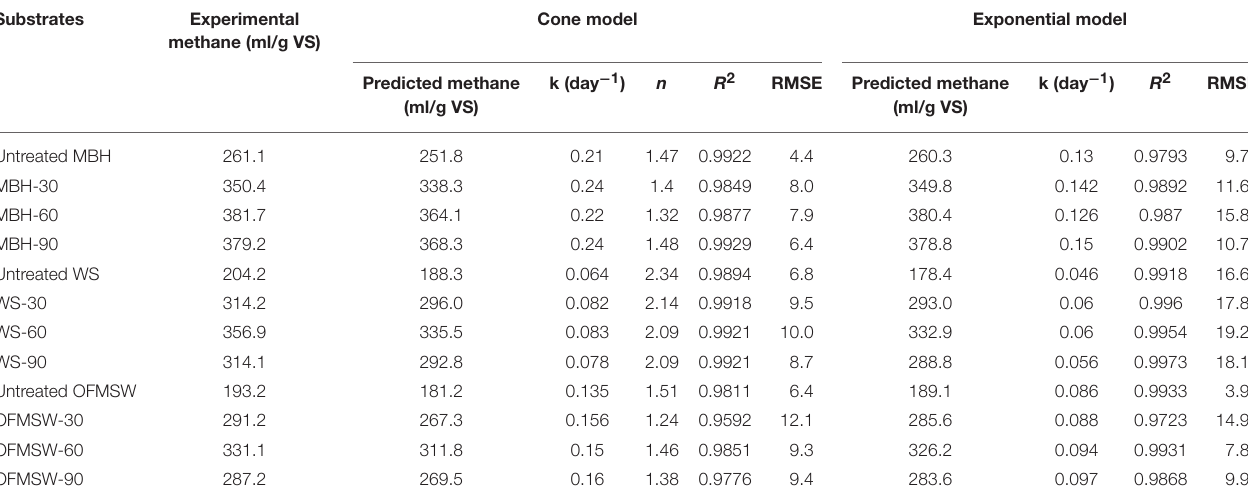
TABLE 3 | Parameters of Cone and Exponential kinetic model obtained from untreated and pretreated samples.